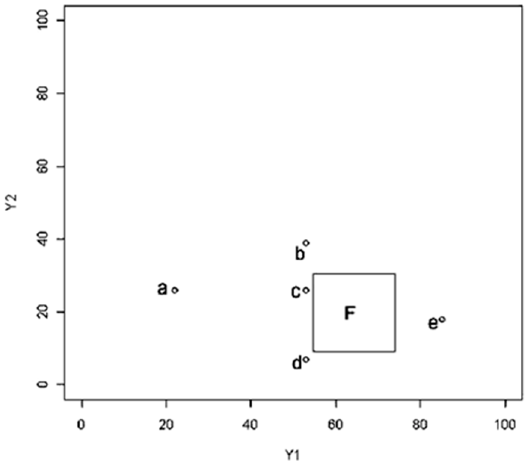
Figure 4. Area F as a practically efficient target zone and evaluation other point based on proximity to efficient zone.